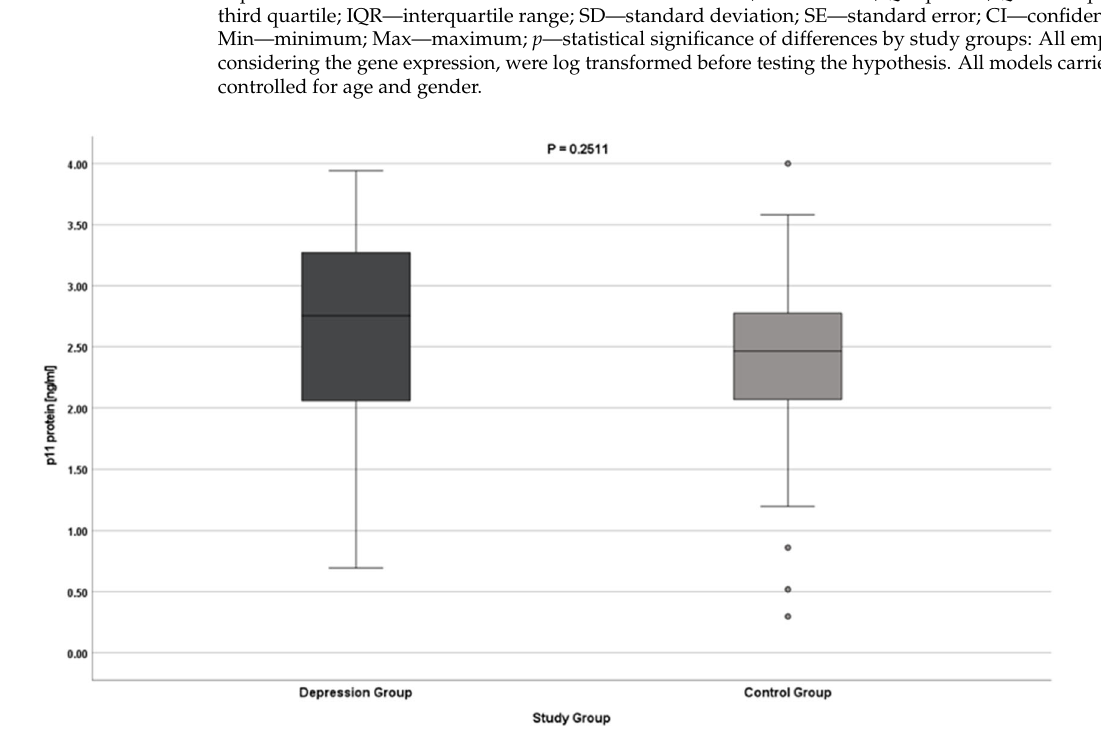
Figure 1. p11 gene expression at the protein level.